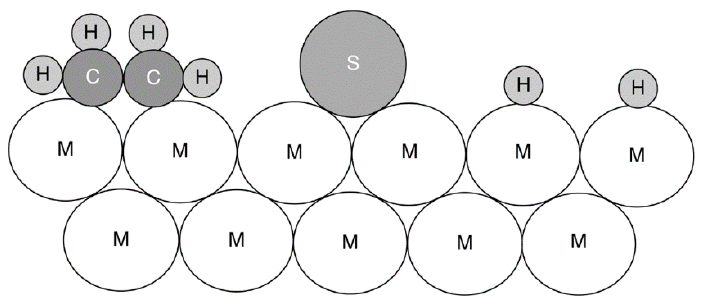
Figure 1. Conceptual model of poisoning by sulfur atoms of a metal surface during ethylene hydrogenation. Reproduced from [8]. Copyright 2006,